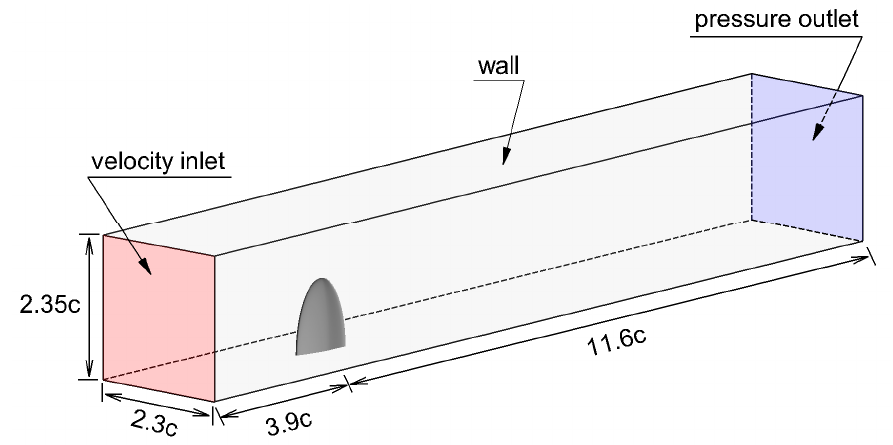
Figure 2. Computational domain and boundary conditions.